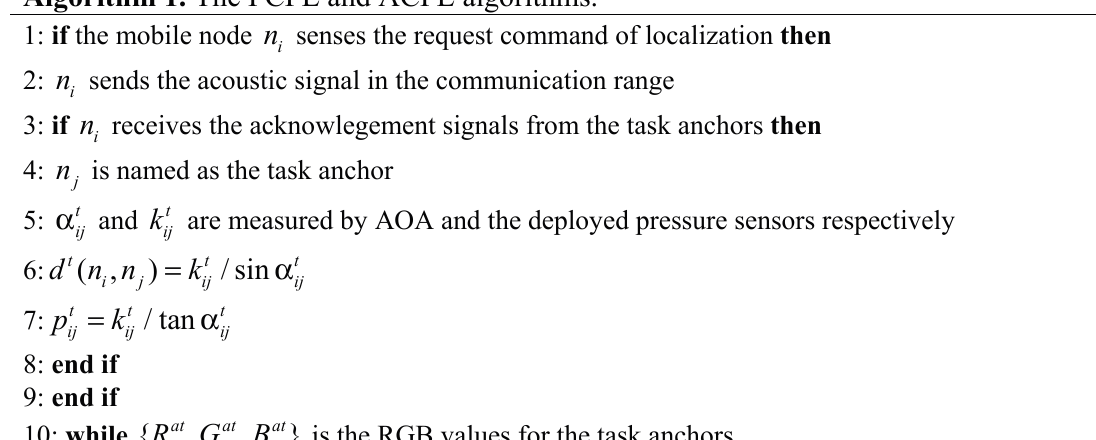
Algorithm 1. The PCFL and ACFL